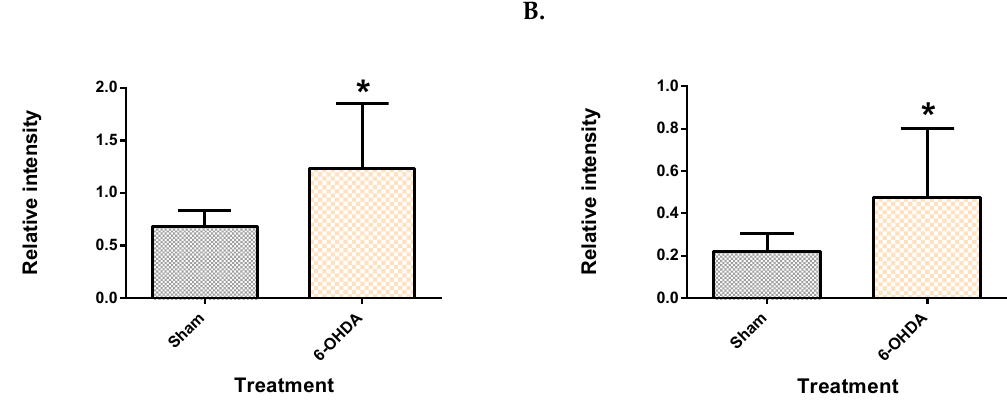
Figure 2. Saturated free fatty acids in the plasma. Palmitic acid ( A ) and stearic acid ( B ) were upregulated in the plasma of 6-OHDA-lesioned rats. Data represent mean ± S.D of at least 5 animals in each group. (* indicates q value < 0.05 using Mann–Whitney test, followed by Benjamini–Hochberg correction.).